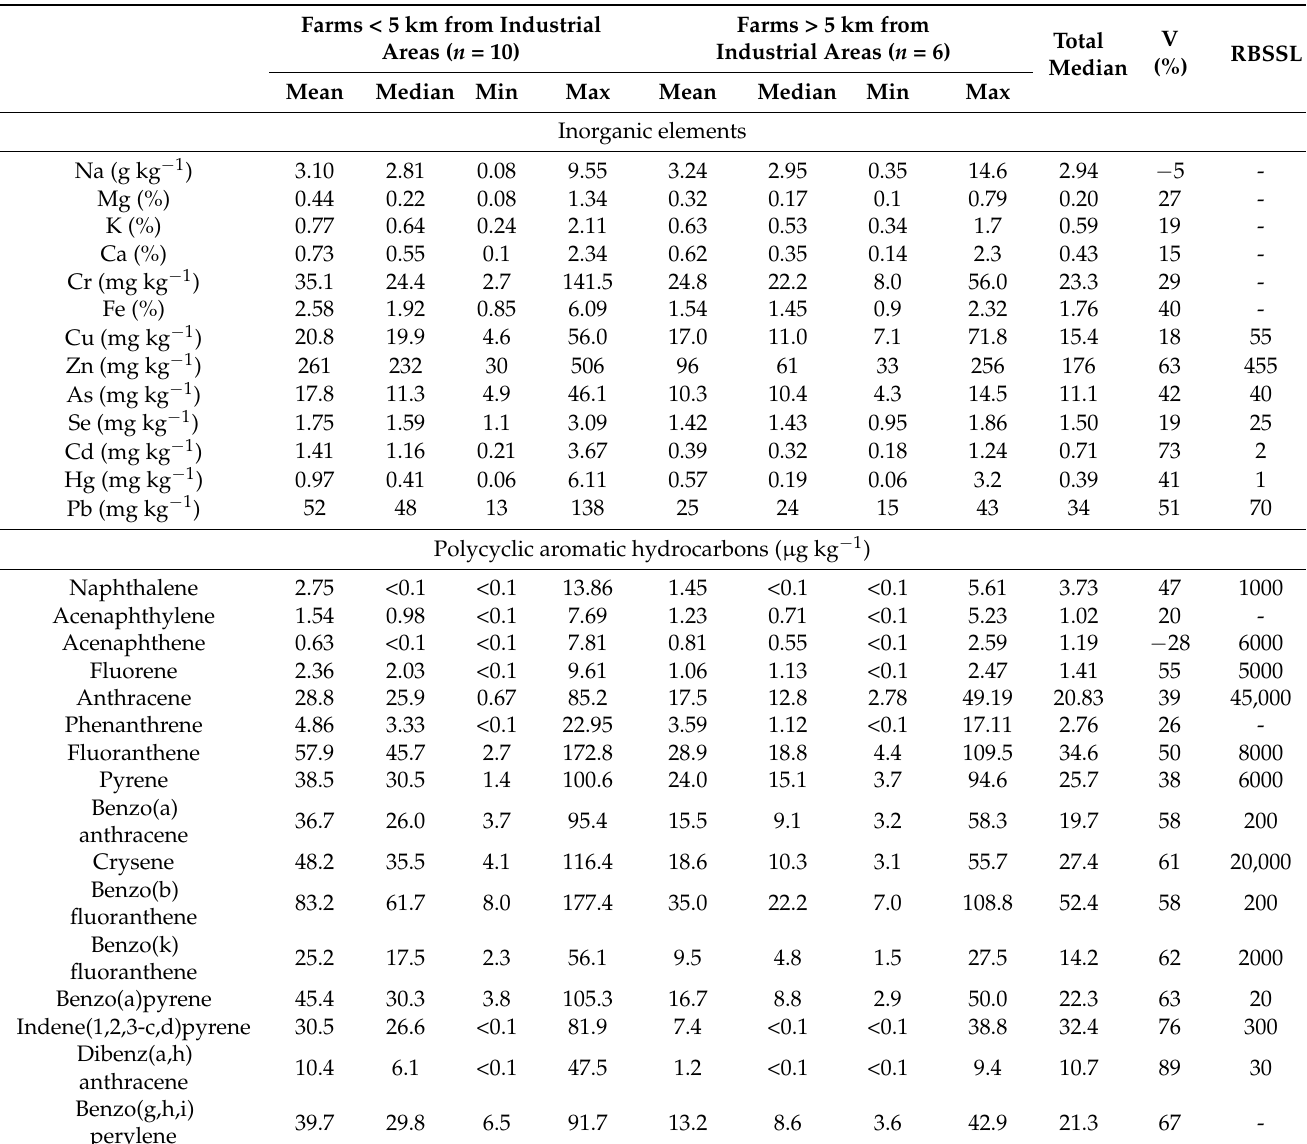
Table 1. Comparison of metals and polycyclic aromatic hydrocarbons in soils from farms located <5 or >5 km from industrial